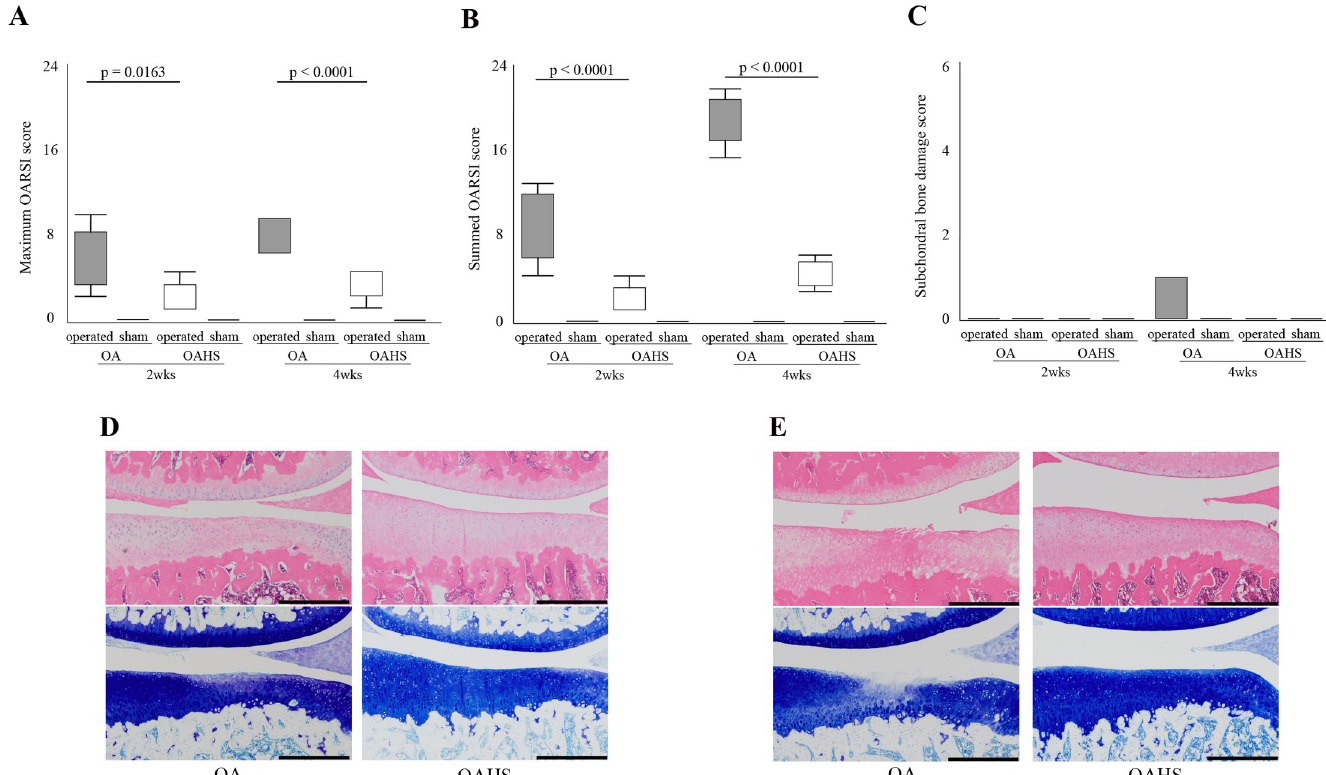
Fig 2. Results of histological changes in the articular cartilage and subchondral bone. The maximum OARSI score (A) and summed OARSI score (B) were significantly lower in the OAHS group than those in the OA group at 2 and 4 weeks. For the subchondral bone score (C), no significant difference was found between the two groups at 2 and 4 weeks. Representative histological changes in the articular cartilage are shown in (D) (2 weeks) and (E) (4 weeks). At 2 weeks, in the OA and OAHS groups, the articular surface was intact, but the staining intensity with toluidine blue was partially reduced in the OA group. At 4 weeks, fibrillation and fissures were detected and the area of reduced staining with toluidine blue was expanded in the OA group. In the OAHS group, a slight decrease in staining intensity on the surface of the articular cartilage was found, but the surface remained almost intact. Scale bar = 500 μ